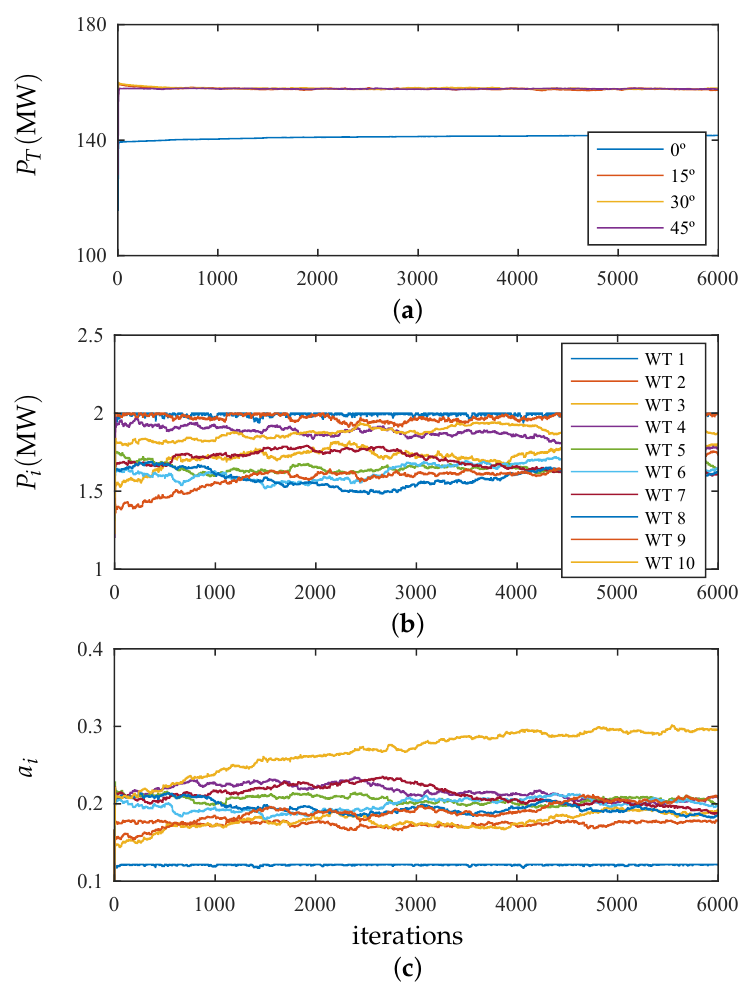
Figure 8. ( a ) Total powers for scenario 2 (free-stream wind speed of 12 m/s) for four wind speed directions. ( b ) Power generated by wind turbines 1–10 and with wind direction of 45 ◦ . ( c ) Axial coefficients for wind turbines 1–10 and with wind direction of 45 ◦